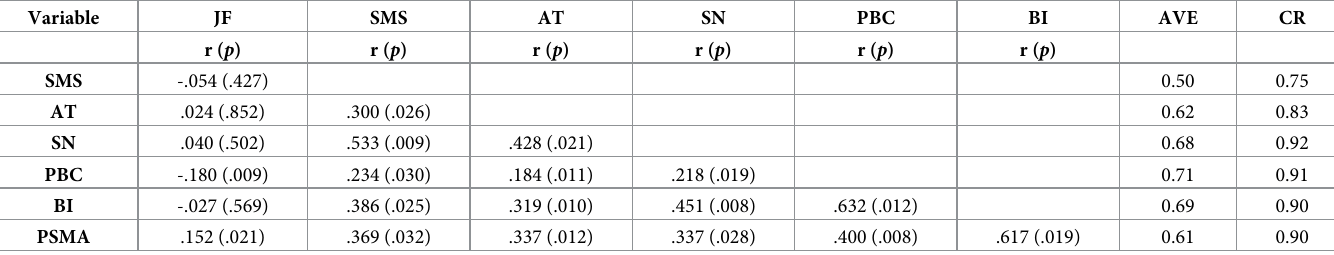
Table 2. Correlations among observed variables.